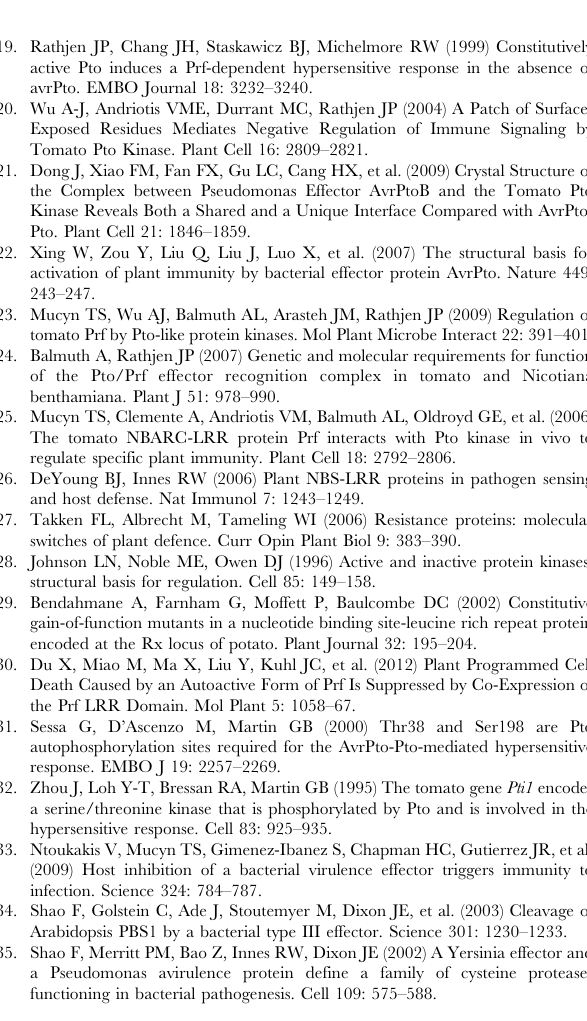
and pictures were taken two days post infiltration. Representative pictures are in Figure 4. Each graph is derived from three leaves, within which relative amounts of cell death were comparable. Figure S10 The kinase inactive pto D164N compromises hypersensitive cell death response (HR) in trans . ( A ). The Hypersensitive Response (HR) triggered by AvrPto recognition is compromised by kinase-inactive pto D164N . The indicated AvrPto, Pto-5Myc and pto D164N -HA constructs were transiently expressed in stable transgenic Pro Prf : Prf-5Myc N. benthamiana leaves. The picture was taken at three days post infiltration. Protein expression was confirmed by immunoblots (IB) with the antibodies indicated on the right. Coomassie Brilliant Blue (CBB) staining of the IB membrane verified equal protein loading. The experiment was repeated several times and typical results are shown. ( B ) The cell death phenotype triggered by the constitutive gain-of-function (CGF) mutant pto L205D is compromised by the co-expression of kinase-inactive pto D164N . The indicated pto L205D -GFP, Pto-5Myc and pto D164N -HA constructs were transiently expressed in stable transgenic Pro Prf : Prf-5Myc N. benthamiana leaves. The picture was taken at three days post infiltration. Protein expression was confirmed by immunoblots with the antibodies indicated on the right. CBB staining of the IB membrane verified equal protein